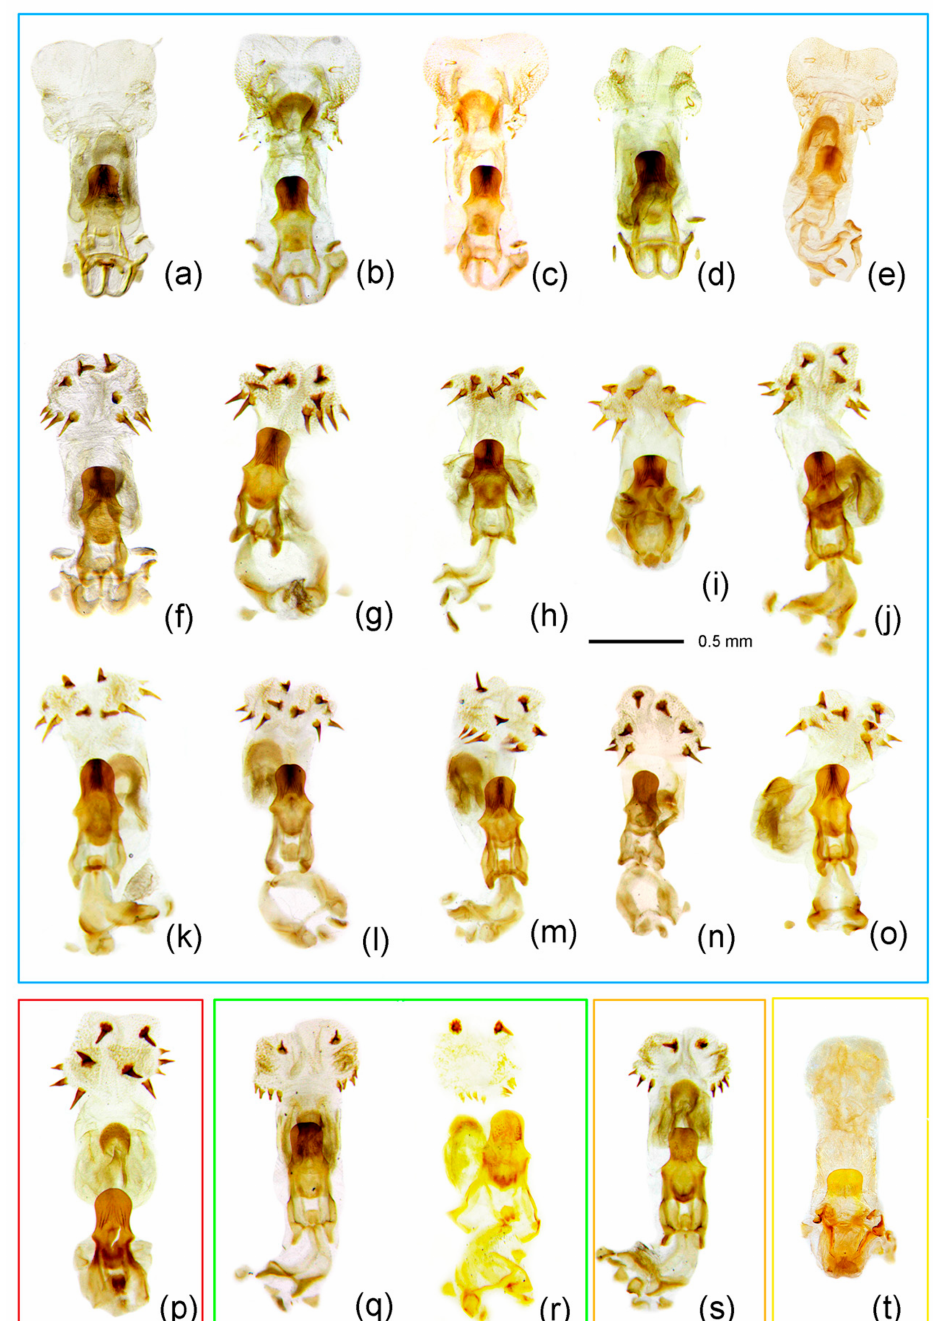
Figure 3. Phallus; the number and size variability of spines on the apical part of endosoma. ( a – o ) Sclomina erinacea Stål, 1861; ( p ) Sclomina guangxiensis Ren, 2001; ( q , r ) Sclomina pallens sp. nov.; ( s ) Sclomina xingrensis sp. nov.; ( t ) Sclomina parva sp. nov. ( a ) JXNC; ( b ) JXJG; ( c ) ZJZC; ( d ) FJQZ; ( e ) GDQY; ( f ) AHFY; ( g ) CQSMS; ( h ) GZLP; ( i ) GZLS; ( j ) GDSG; ( k ) GXYL; ( l ) GXJX; ( m ) GZJP; ( n ) TWNT; ( o ) HNBW; ( p ) GXLZ; ( q ) GXTL; ( r ) GZAL; ( s ) GZXR; ( t ) SXYX (for sample codes, see Table A1). Scale bar = 0.5